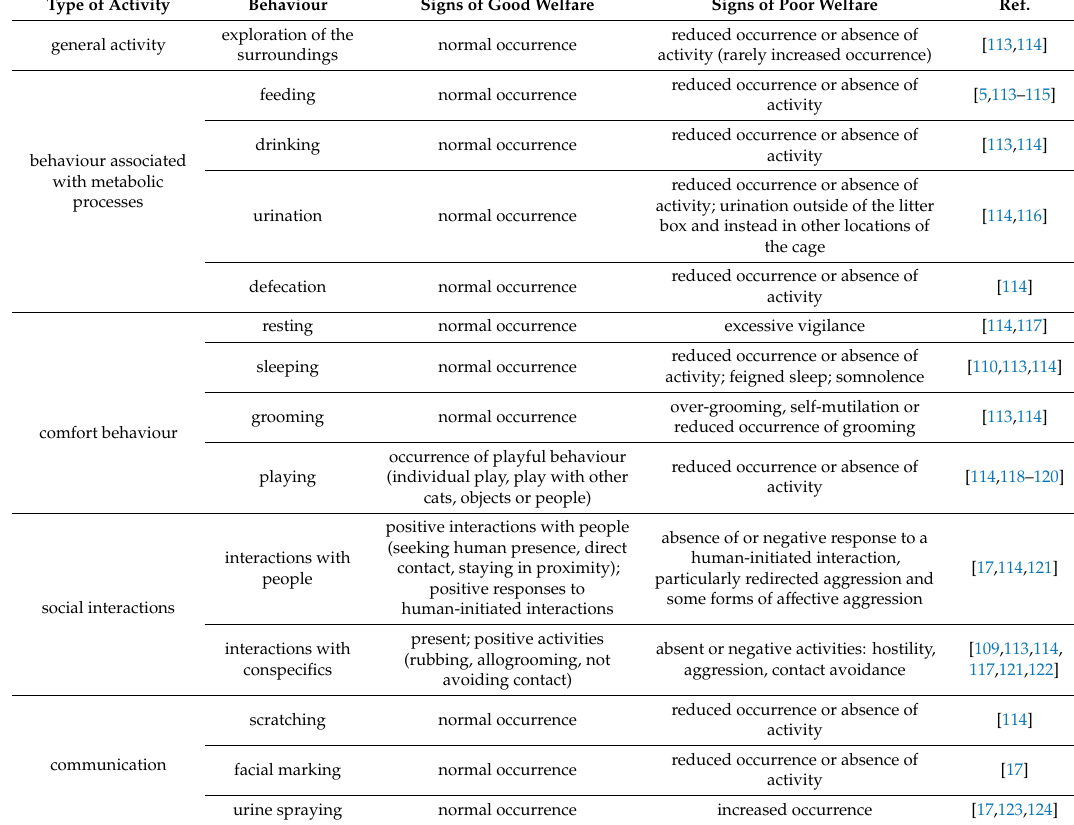
Table 1. Behavioural indicators of good and worsened welfare of